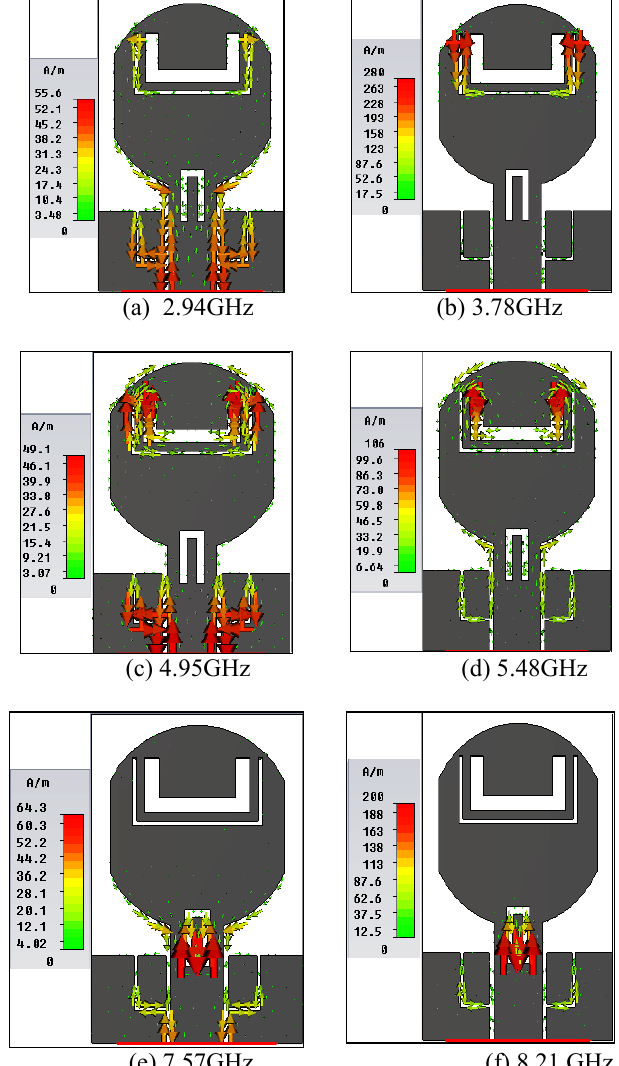
Figure 8: Current distribution at different pass band resonant frequencies as well as notch band central